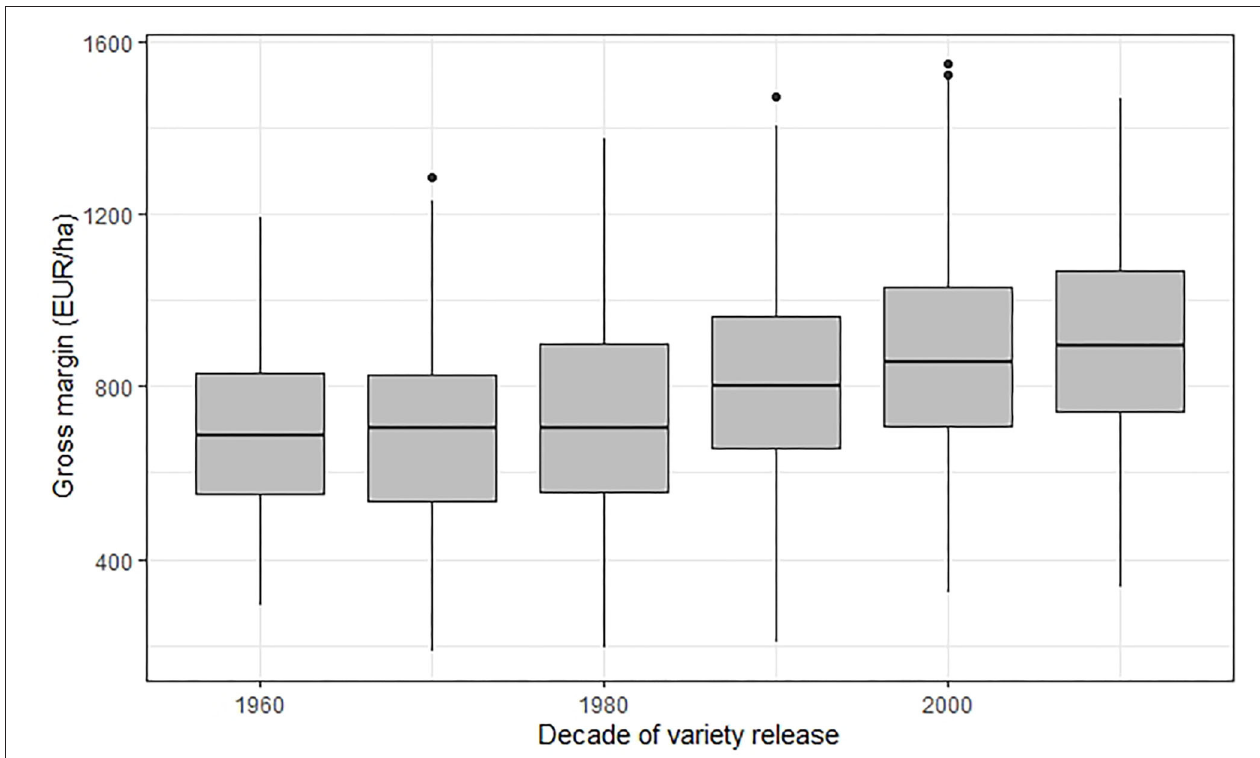
FIGURE 3 | Boxplots of the gross margins (EUR ha − 1 ) per decade of variety release, for all treatment groups and